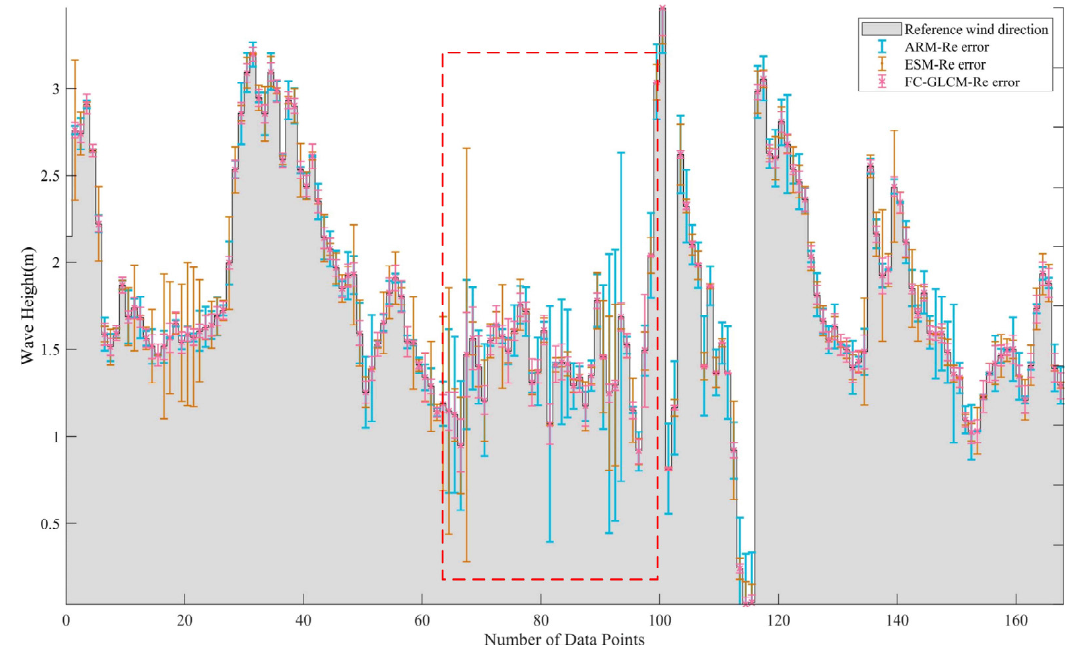
Figure 16. Wind direction error between retrieved direction and reference wind direction at different wave heights. (The shaded area represents wave height data measured by vane and the red dotted box represents the area with large fluctuations in the error range.)